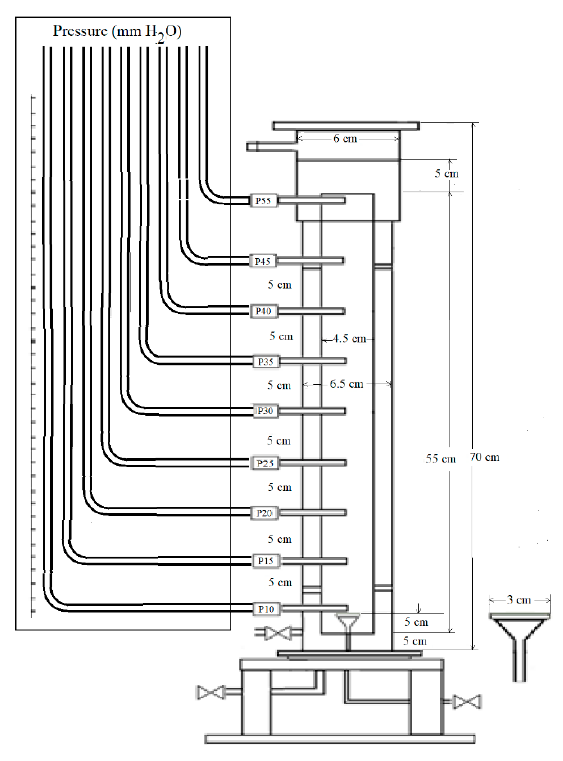
Figure 2. Schematic diagram of airlift reactor and its pressure sensors along the riser tube, using a sintering glass disperser.